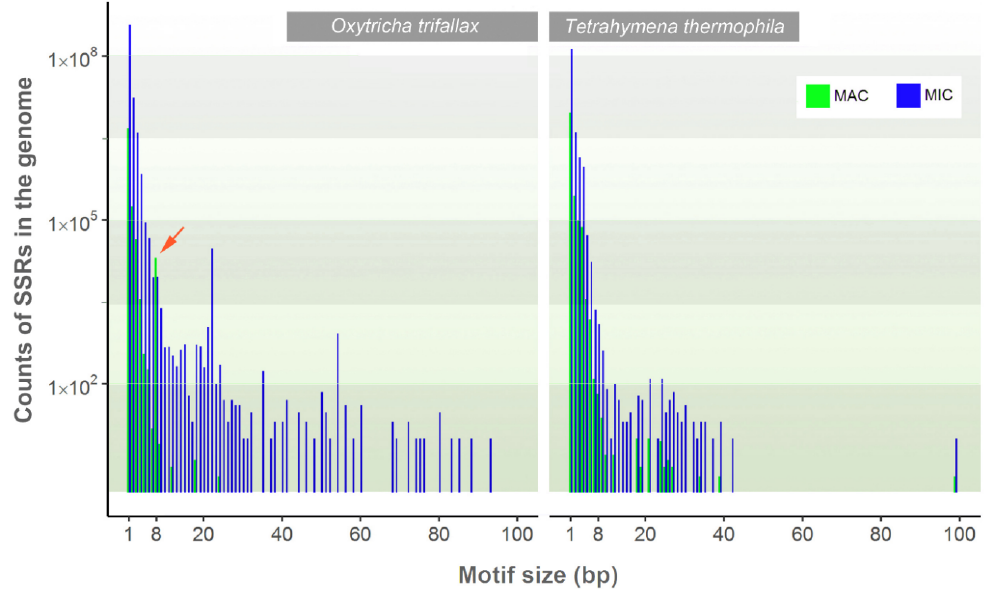
Figure 3. Comparison of SSR counts in the macronucleus and micronucleus of Oxytricha trifallax and Tetrahymena thermophila . The arrow marks the 8-bp-motif SSRs in the macronuclear genome. The y-axis is